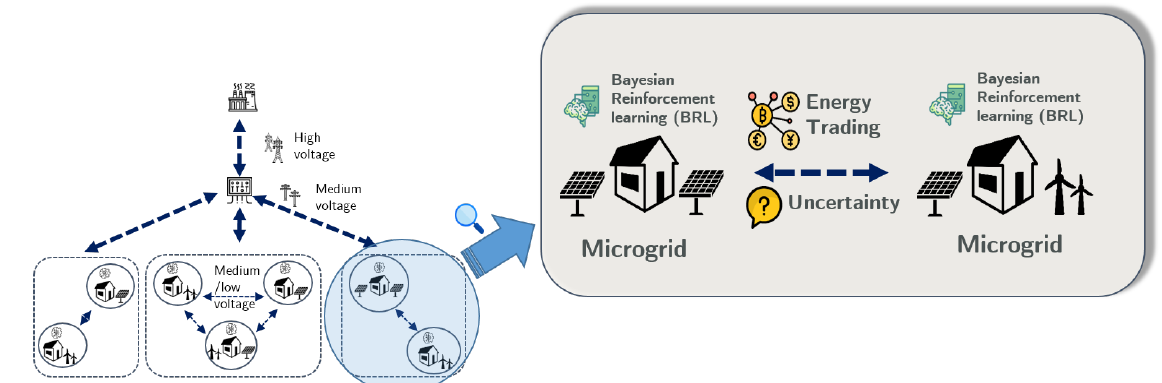
Figure 1. Block diagram of a system of microgrids. The figure illustrates that due to the dynamicity of the system, different coalitions can be formed during each